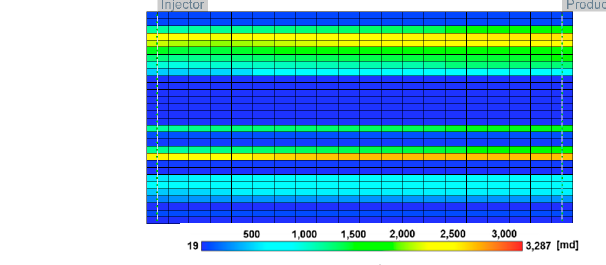
Figure 7. Distributions of ( a ) dextran and ( b ) permeability of the field case at the end of the simulation.